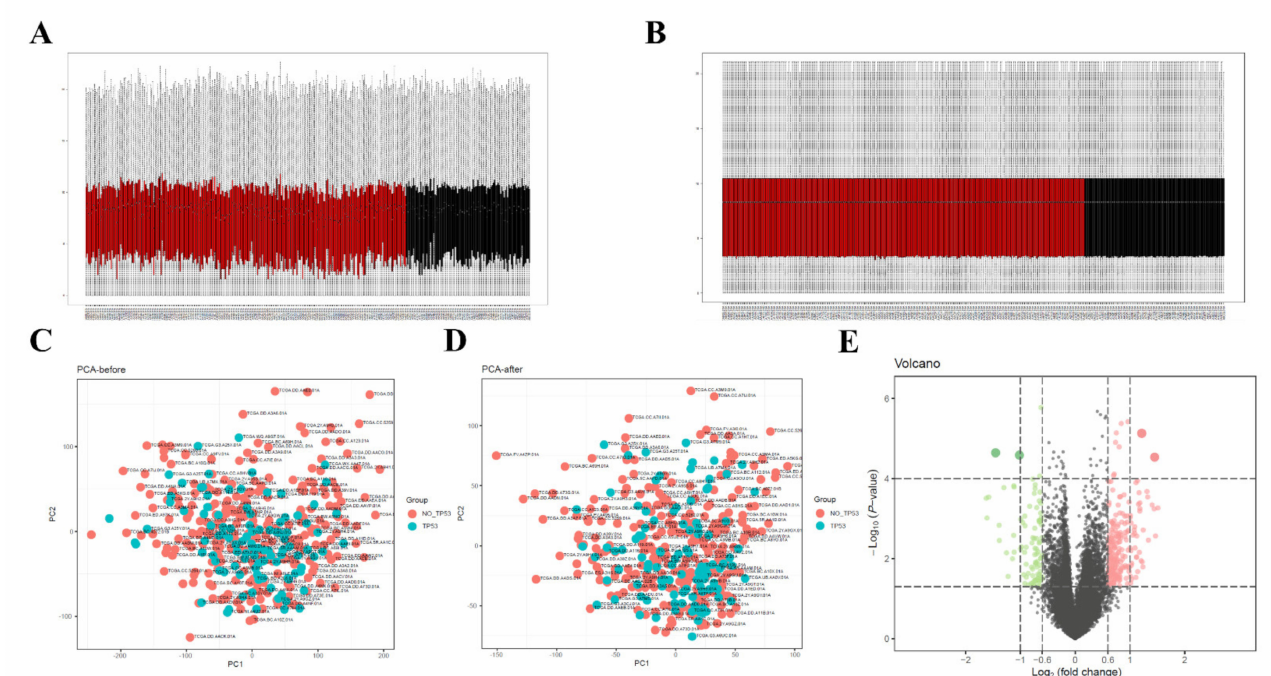
Figure 2. Data preprocessing and differential expression analysis. ( A , B ) Box chart of gene expression among high- and low-TMB groups. Black dots represent mean values of gene expression after sample normalization before ( A ) and after ( B ) sample normalization. ( C , D ) before ( C ) and after ( D ) principal component analyses (PCA) of gene expression between high- and low-TMB groups. ( E ) Volcano map of DEGs; red represents upregulated differential genes, green represents downregulated differential genes, and grey represents no-significant-difference genes. TMB: Tumor Mutation